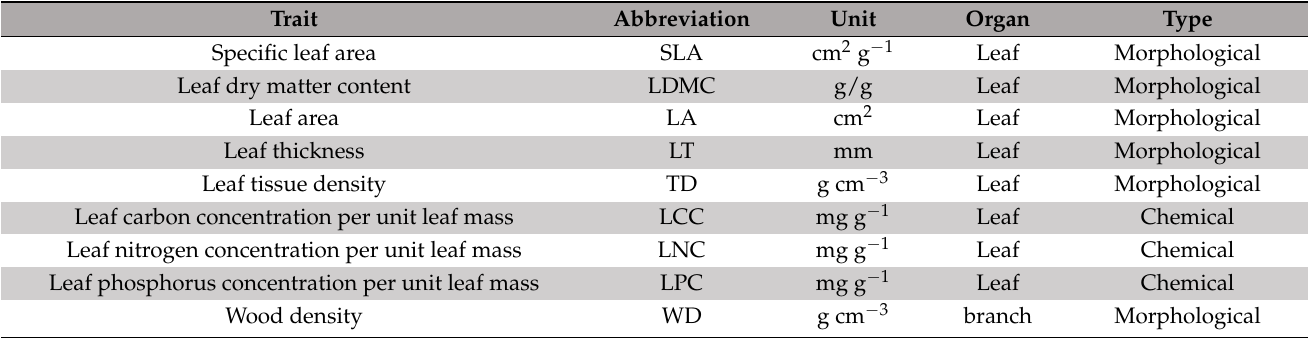
Table 2. Plant functional traits measured in this